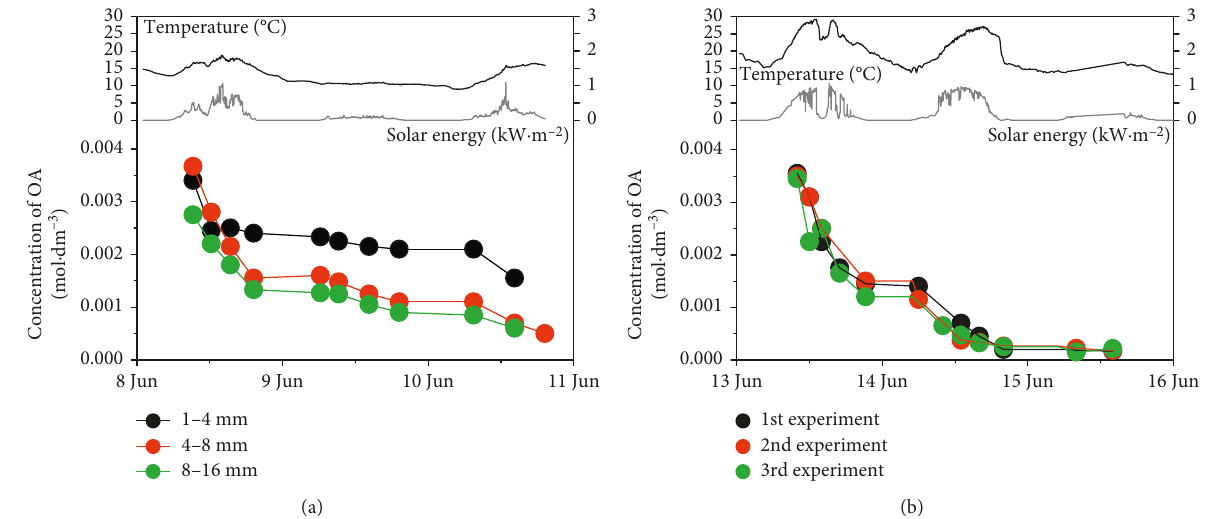
Figure 11: Photocatalytic degradation of OA with coated, calcined Liapor. (a) Different grain sizes (1–4 mm, 4–8mm, and 8–16mm). (b) Used for the first, second, and third